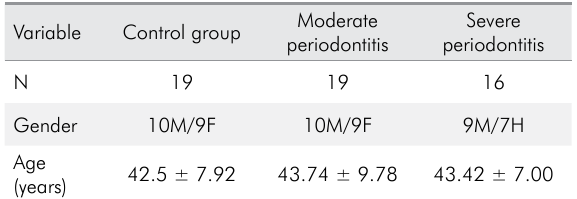
Table 2. Demographic data